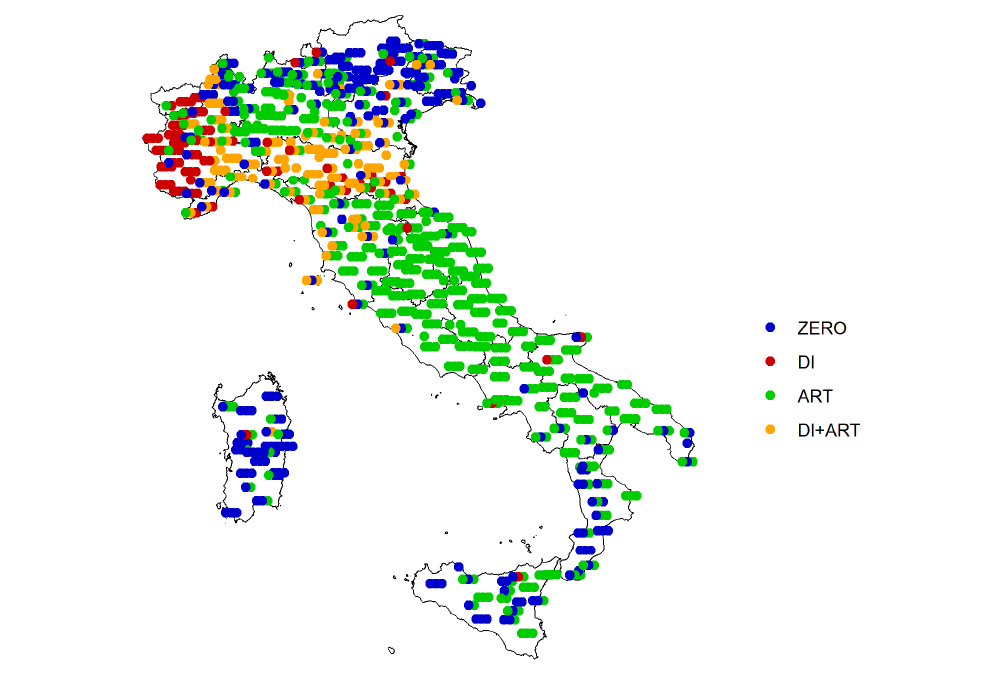
Figure 1. Rendering of the AIS maps number 637, 1037 and 1343. In the following figure each location censed in the AIS collection is represented by three overlapping dots showing the use of one of our four determiners in the sentences “[to go look for] violets” (left), “if there was water” (center) and “[to go to the cellar] to take wine” (right)